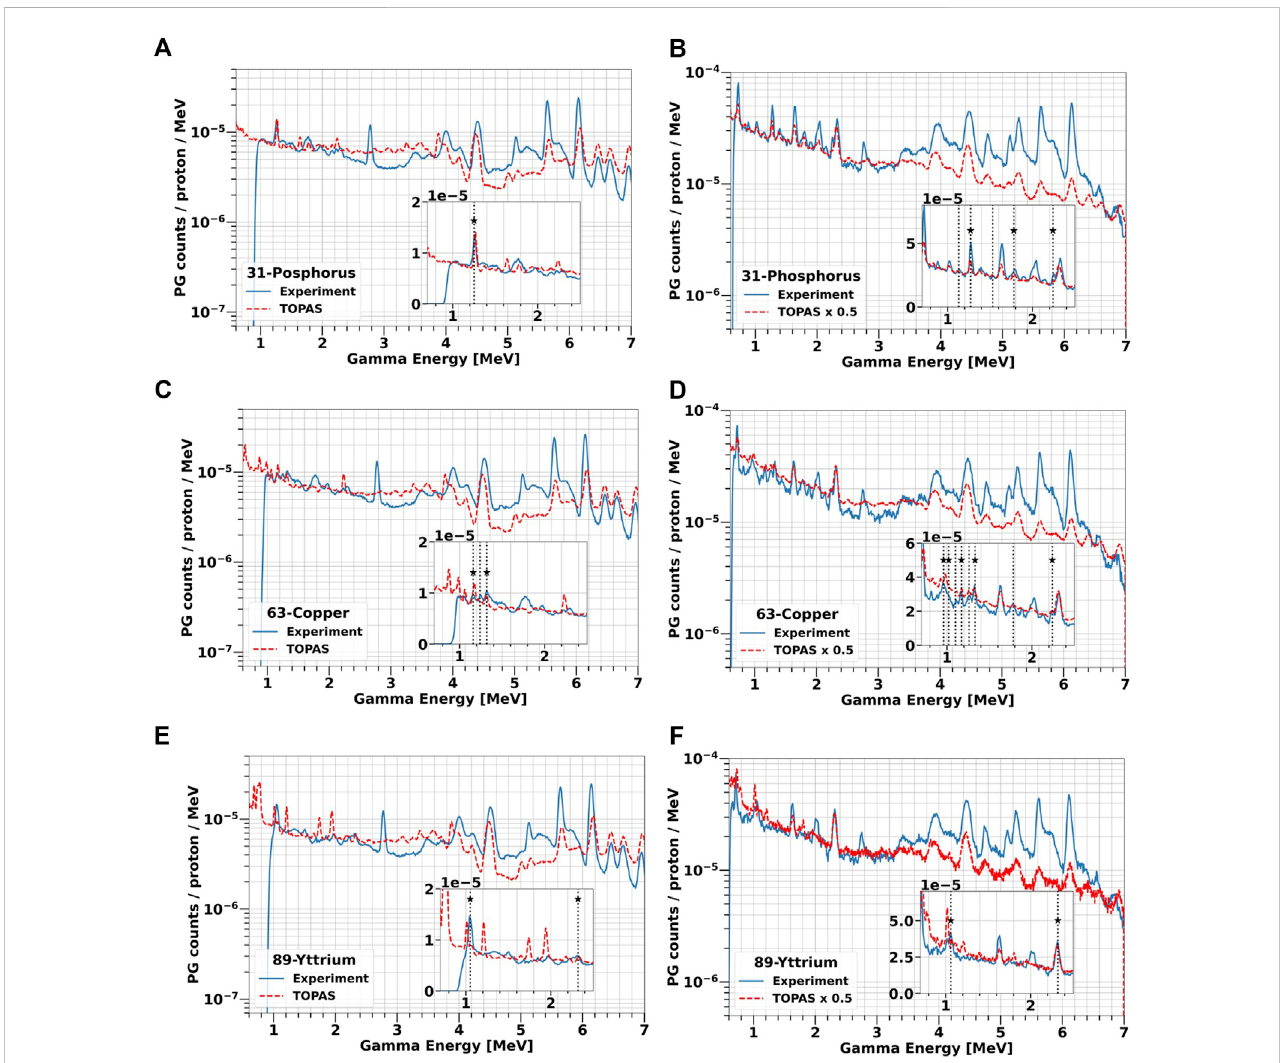
FIGURE 10 Comparison of experimental and simulated PG energy spectra from water-based solutions of 31 P [2 M, (A, B) ], 63 Cu [1 M, (C, D) ] and 89 Y [1 M, (E, F) ] irradiatedwith25and70 MeVprotons.AllsimulationswereperformedwithTOPAS.ThemeasurementsareplottedasbluesolidlineswhileTOPASpredictions are red dashed lines. The vertical lines indicate all characteristics PGs experimentally detected, while the label stars mark those in agreement with